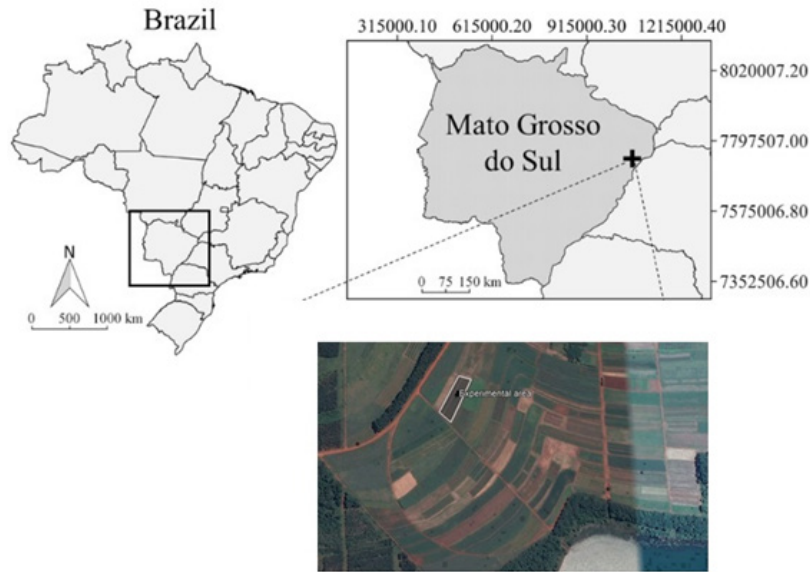
Figure 1. Study area at the Selvíria, Mato Grosso do Sul state, Brazil (20 o 22′S, 51 o 22′W, altitude of 335 m).